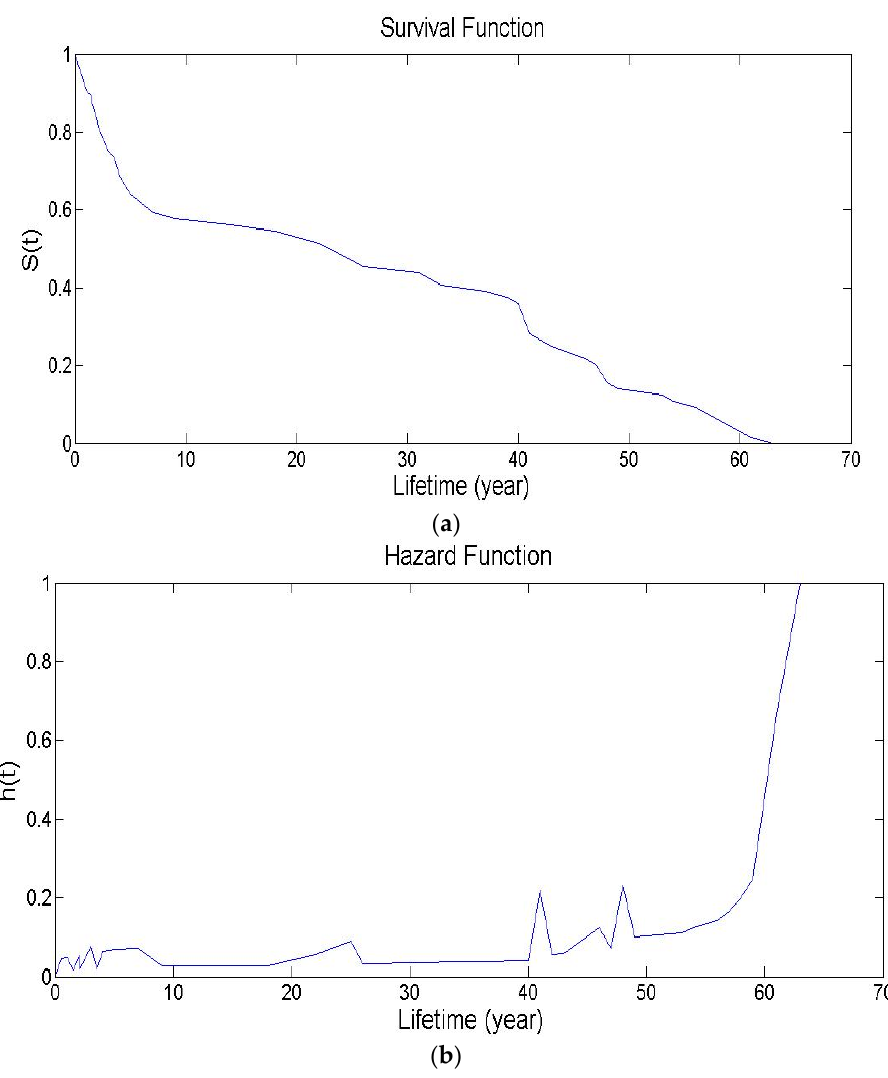
Figure 2. Survival ( a ) and Hazard ( b ) functions of girth-weld accident.